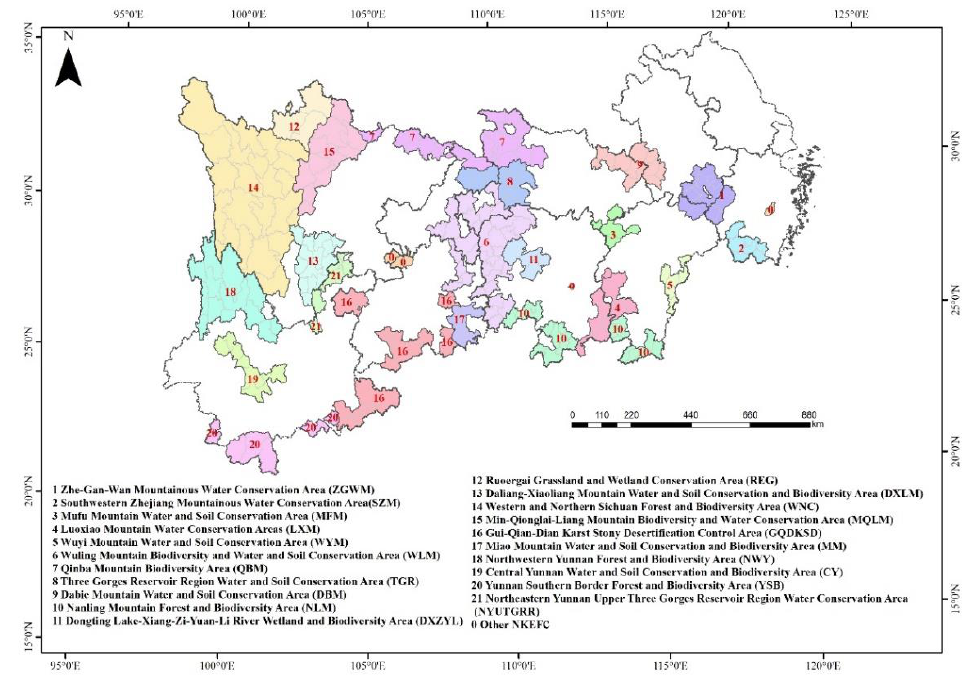
Figure 2. National Key Ecological Areas (NKEFAs) and Nation Key Ecological Function Counties (NKEFCs) in the Yangtze River Economic Belt.